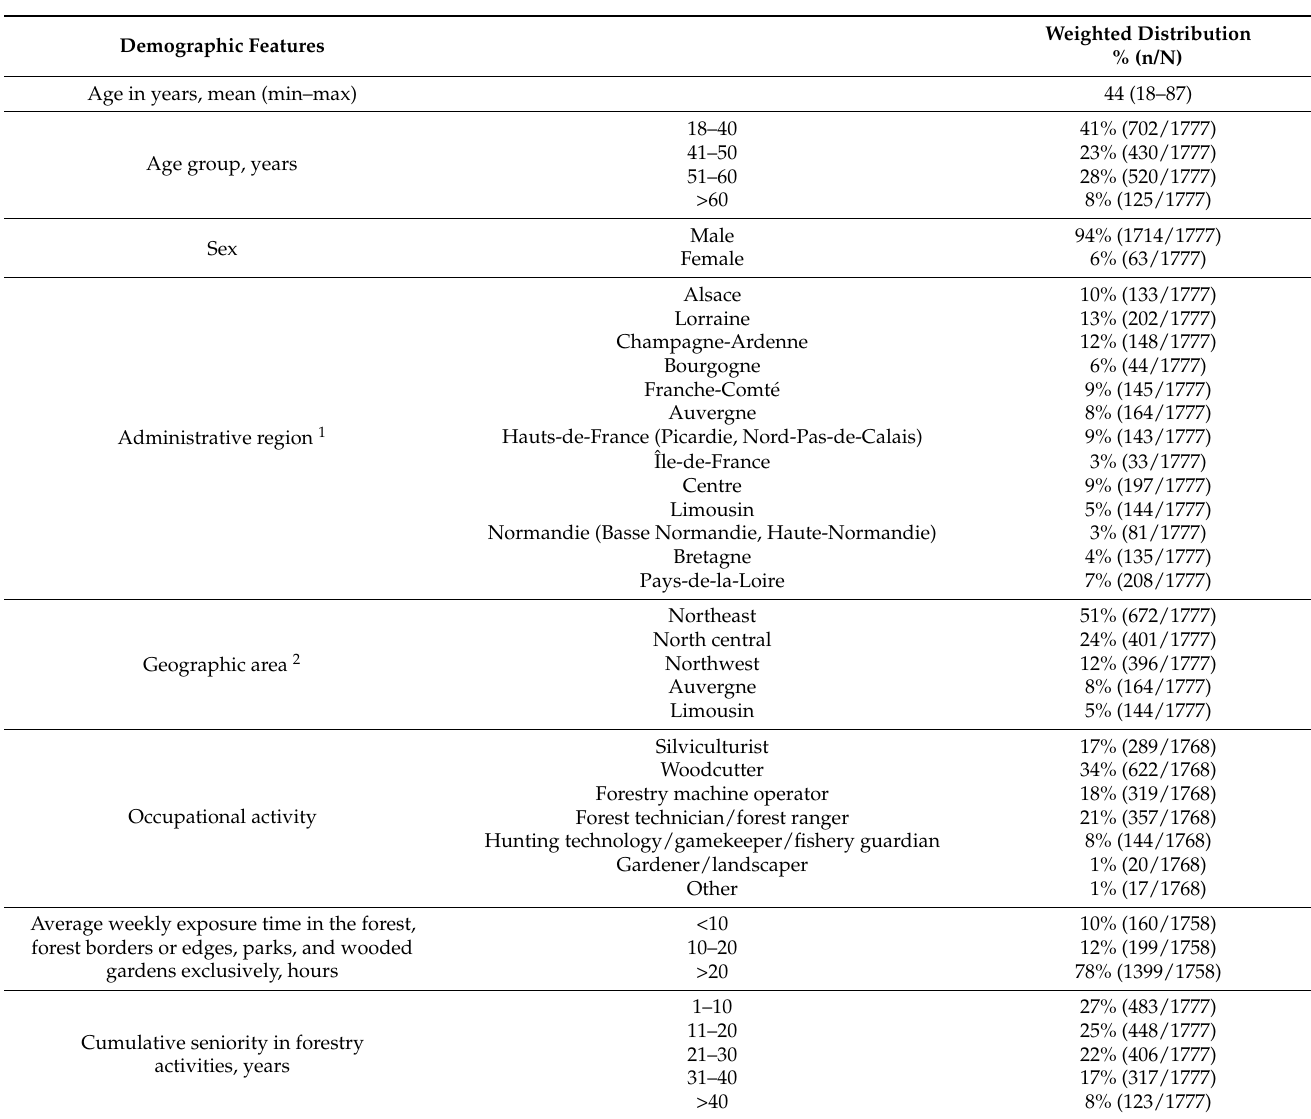
Table 1. Demographic features of forestry workers targeted in the Puumala orthohantavirus